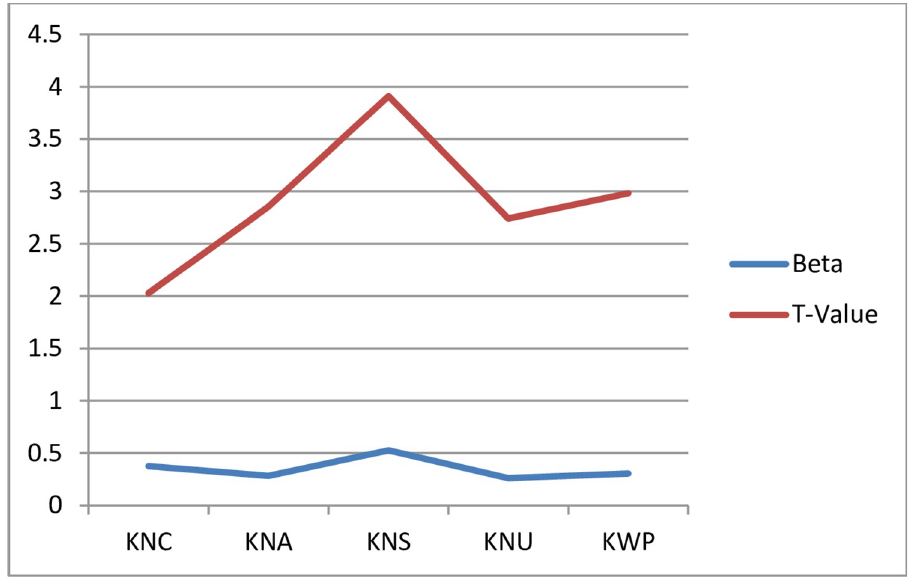
Fig 2. Effects on